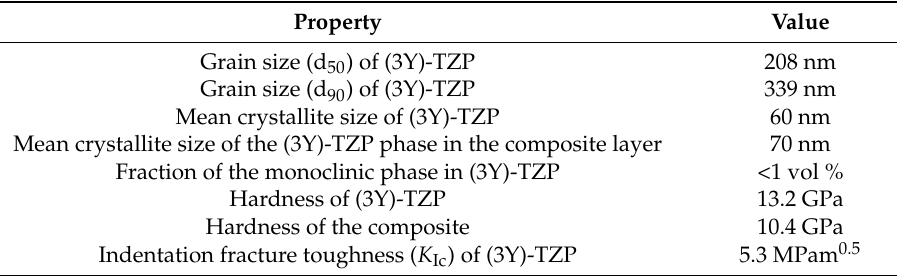
Figure 1. Microstructure of SPS-consolidated specimens: ( a ) (3Y)-TZP; ( b ) composite.